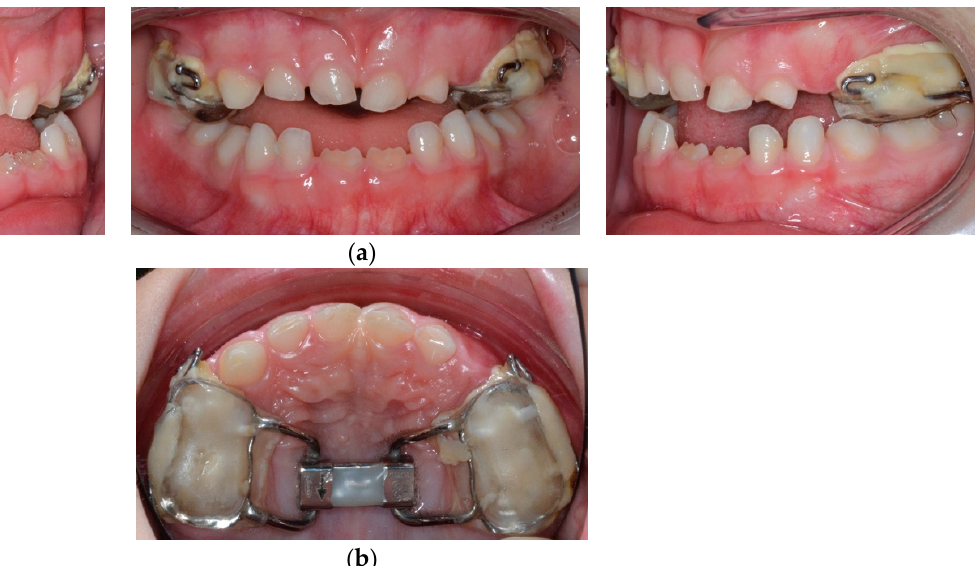
Figure 3. ( a ) Frontal and lateral views of a bonded rapid palatal expander; ( b ) occlusal view of the upper arch.